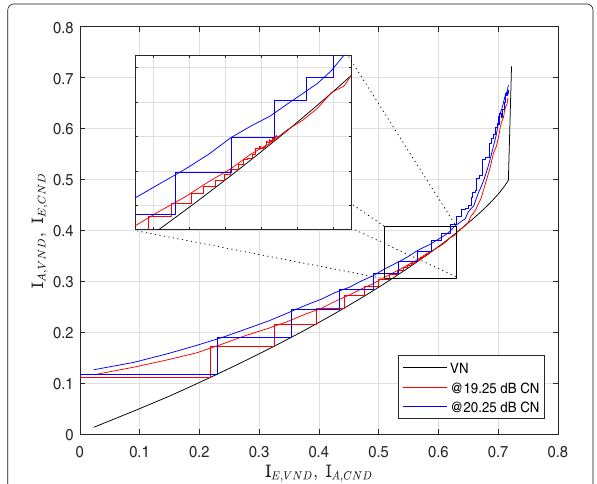
Fig. 5 EXIT chart and mutual information trajectory of a RCM-LDGM code when transmitting a non-uniform source with entropy H ( p 0 ) = 0.72 over an AWGN